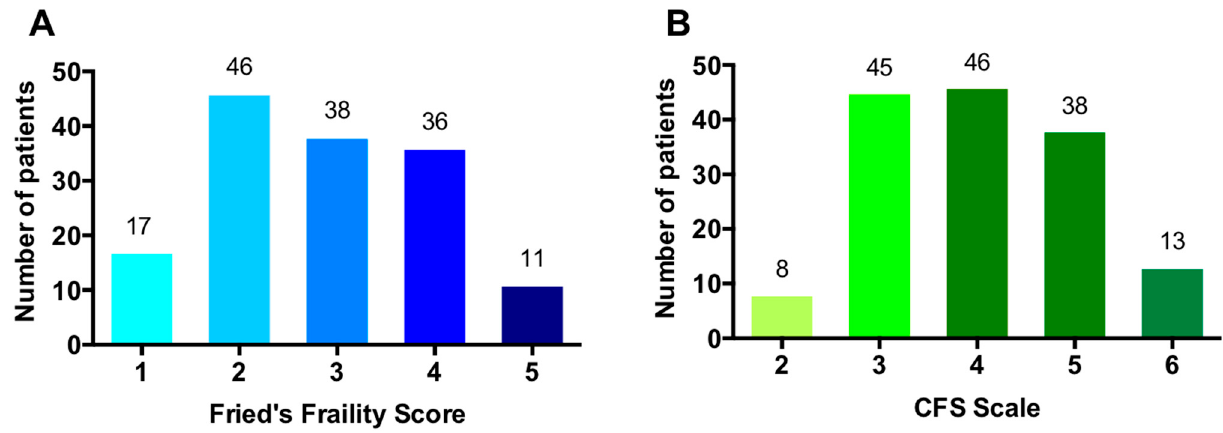
Figure 1. Patient distribution according to frailty scales ( A : Fried’s Frailty Score, B : Clinical Frailty Scale [CFS]).